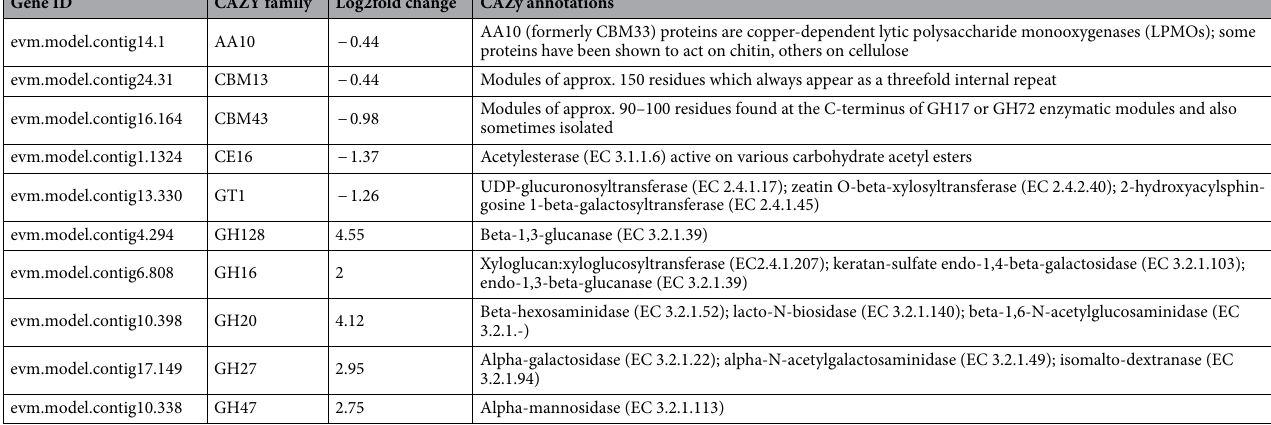
Table 3. Candidate CAZymes, which show the greatest differential expression between fruiting and vegetative stages of LM, and their annotations. The gene IDs represent name of predicted protein-coding genes in